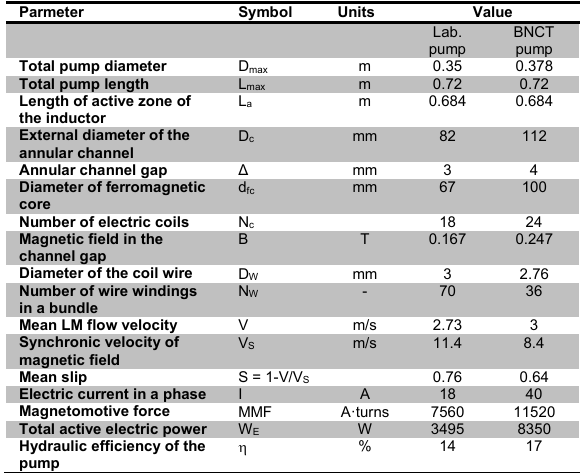
Table 1. Design and tested parameters of the two ALIN